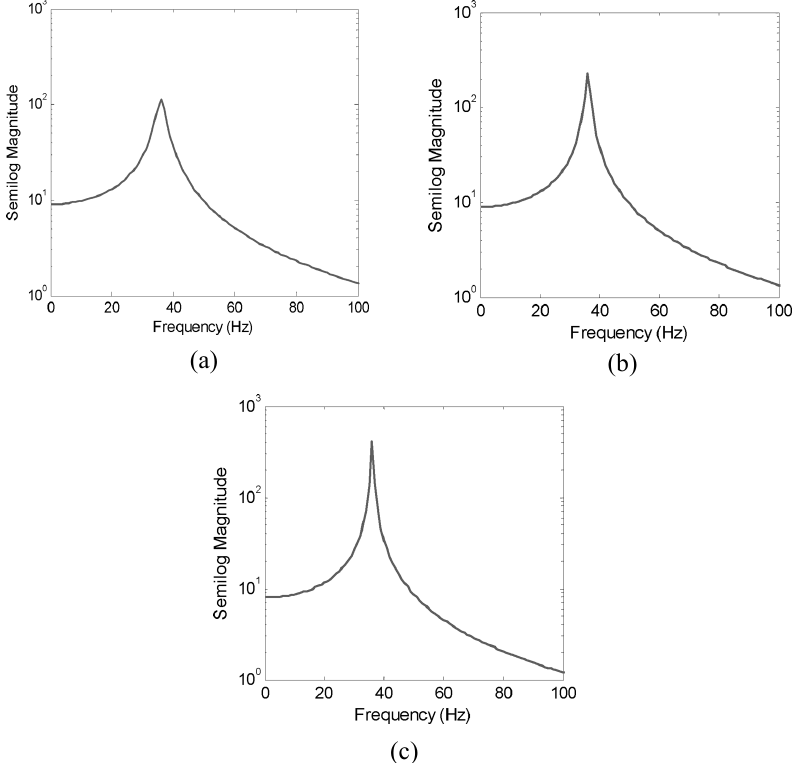
Fig. 4. (a) FRF plot at 0.1 mm initial amplitude of excitation for jointed and welded cantilever beams of dimensions = 600.6 × 40.2 × 6 mm 3 ; (b) FRF plot at 0.2 mm initial amplitude of excitation for jointed and welded cantilever beams of dimensions = 600.6 × 40.2 × 6 mm 3 ; (c) FRF plot at 0.3 mm initial amplitude of excitation for jointed and welded cantilever beams of dimensions = 600.6 × 40.2 × 6 mm 3 .